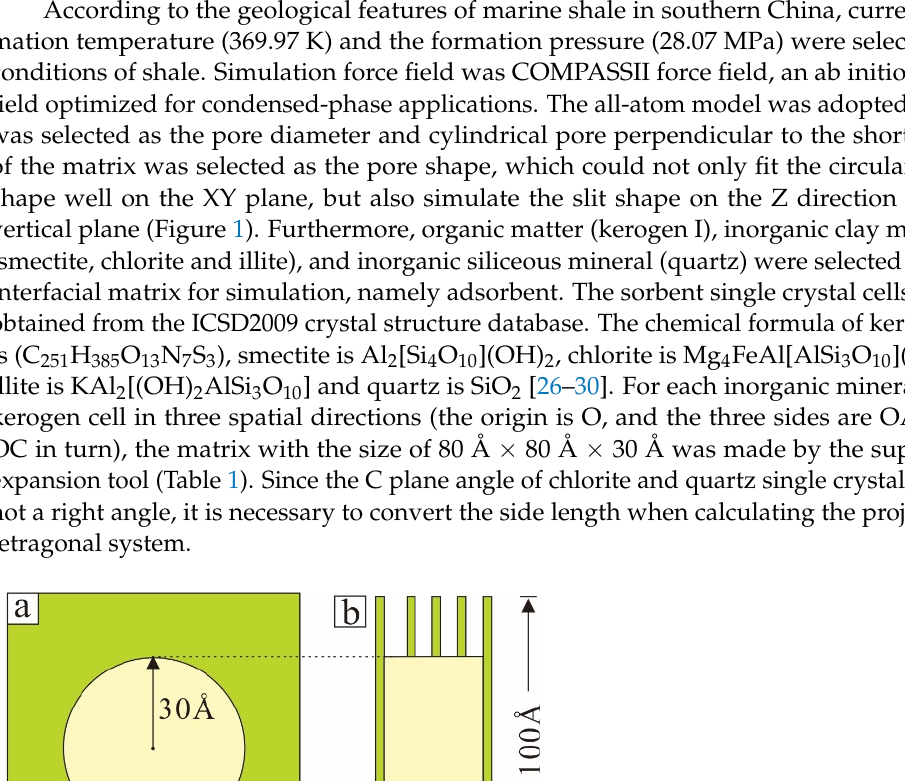
Table 1. Geometry parameters of pore models.